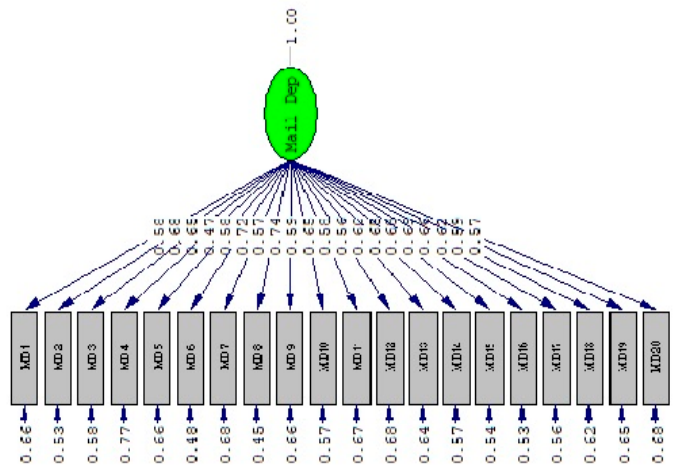
Figure 2. CFA for email addiction tendency scale.